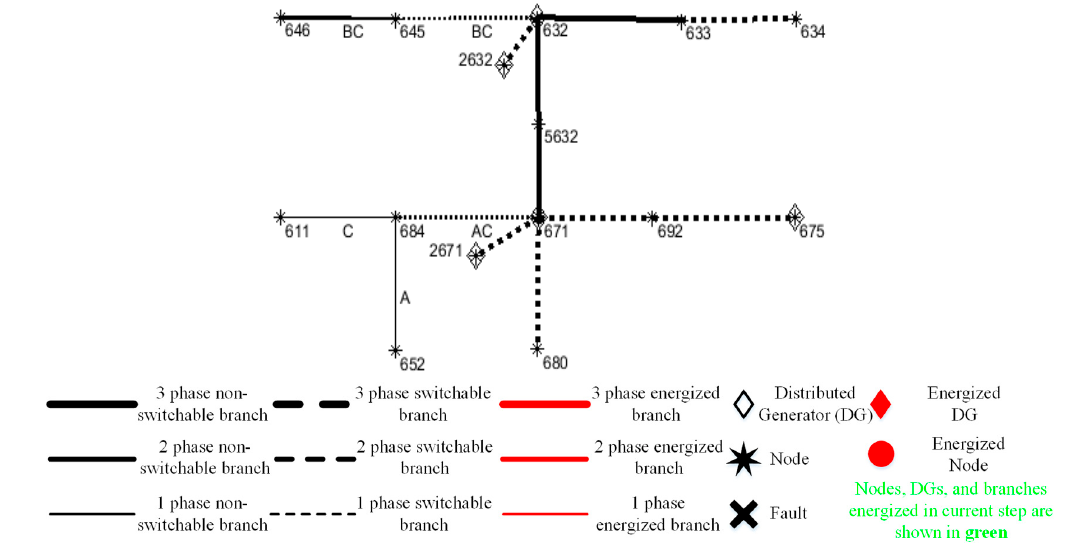
Figure 10. One-line diagram of modified IEEE 13 node test feeder.